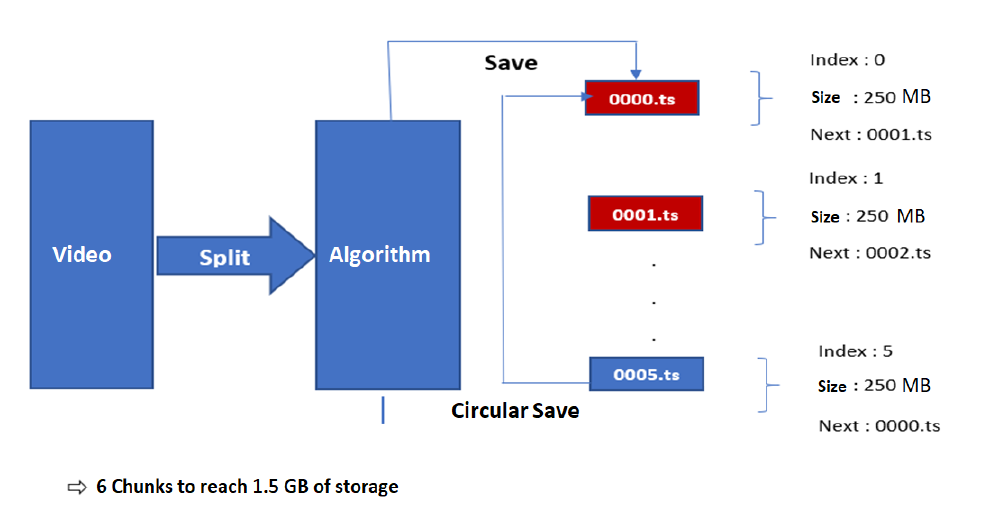
Figure 8. Example of the circular buffer